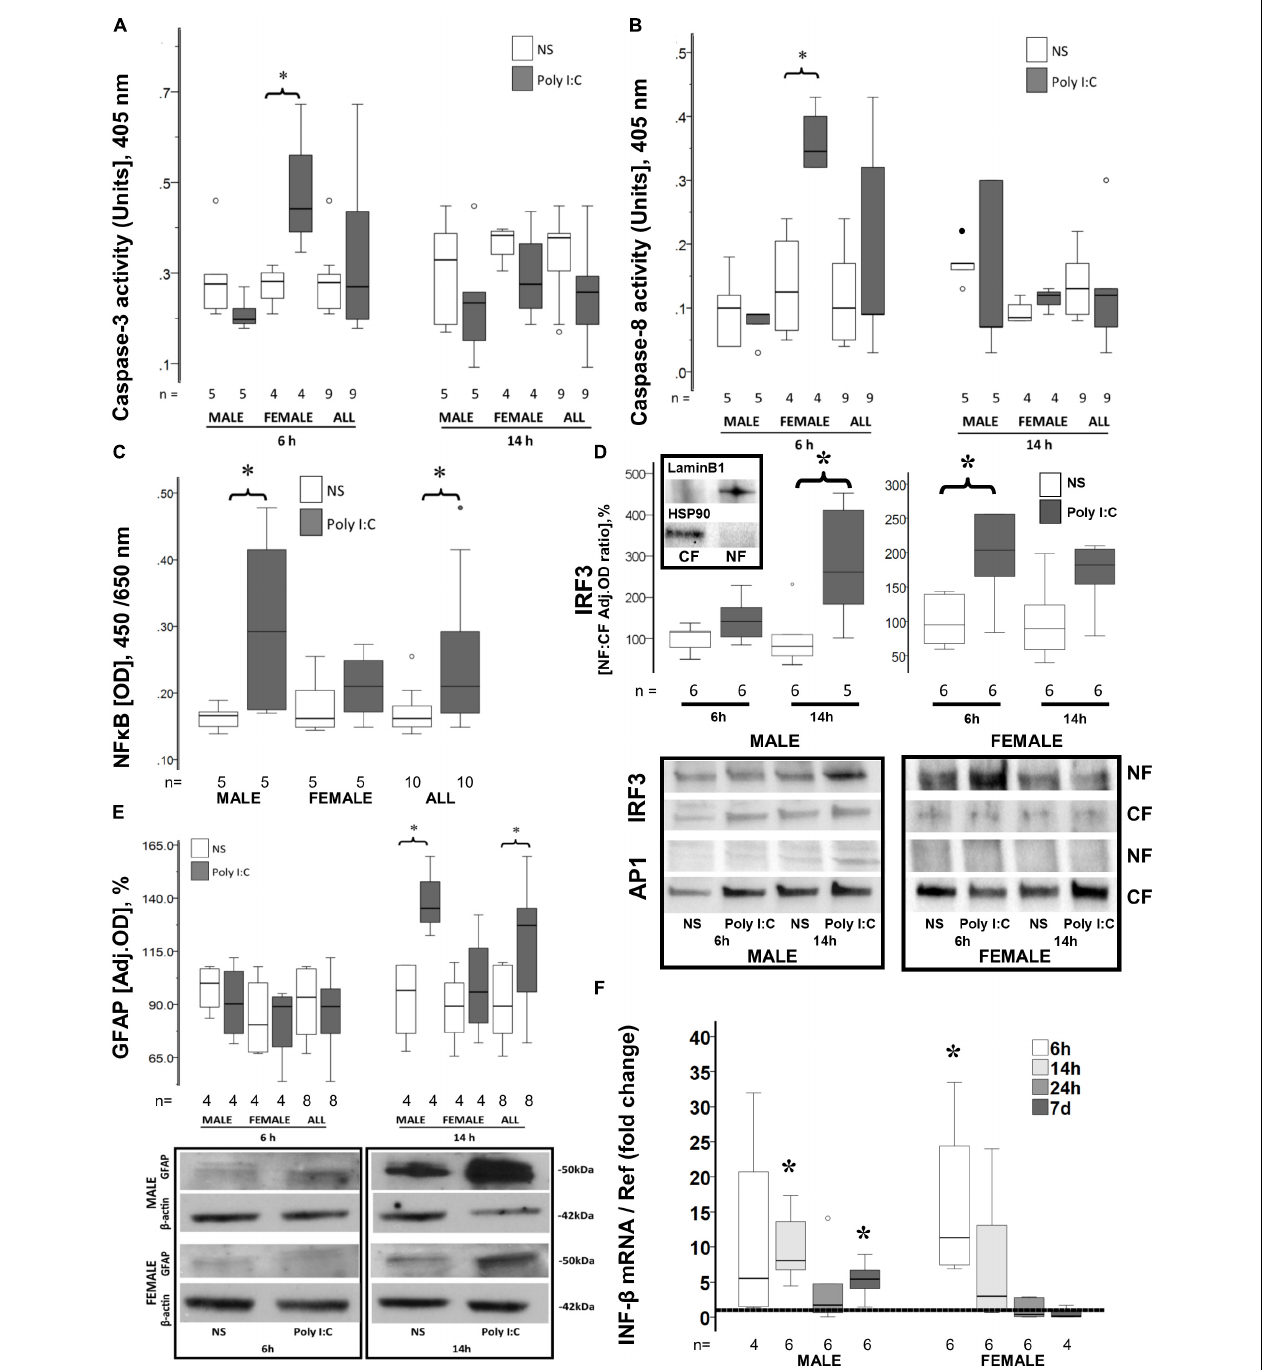
FIGURE 1 | Early sex-specific responses to poly I:C in the brain of P8 mice. Increased caspase-3 (A) and caspase-8 activity (B) , IRF3 nuclear translocation (D) , and INF- β gene upregulation (F) occur 6 h after poly I:C in the brain of female mice. Increased NF κ B (C) and IRF3 (D) nuclear translocation, GFAP expression (E) and INF- β gene upregulation (F) occur 14 h after poly I:C in the brain of male mice. Data are presented using box and whiskers plots, where boxes are limited by the 75 th and 25 th percentiles interquartile range (IQR)] and whiskers are limited by the last data point within 1.5 times the IQR from the median (continuous line inside the box). (A–E) White boxes represent NS-treated pups, while gray boxes represent poly I:C-treated pups. (D) Representative immunoblots showing translocation of IRF3 and AP1 from the cytosolic fraction (CF) to the nuclear fraction (NF) in males and females at 6 and 14 h after poly I:C. Top immunoblots show purity of the NF and CF using Lamin B1 and HSP90, respectively. (E) Representative immunoblots showing GFAP expression in cytosolic fractions. (F) Shows the fold change in INF- β mRNA levels in the brain of male and female mice at 6, 14, 24 h and 7 days after poly I:C relative to NS-treated mice (discontinuous line sitting at 1). ◦ , outlier (between 1.5 and 3 times the IQR); • , extreme ( > 3 times the IQR); ∗ p < 0.05.